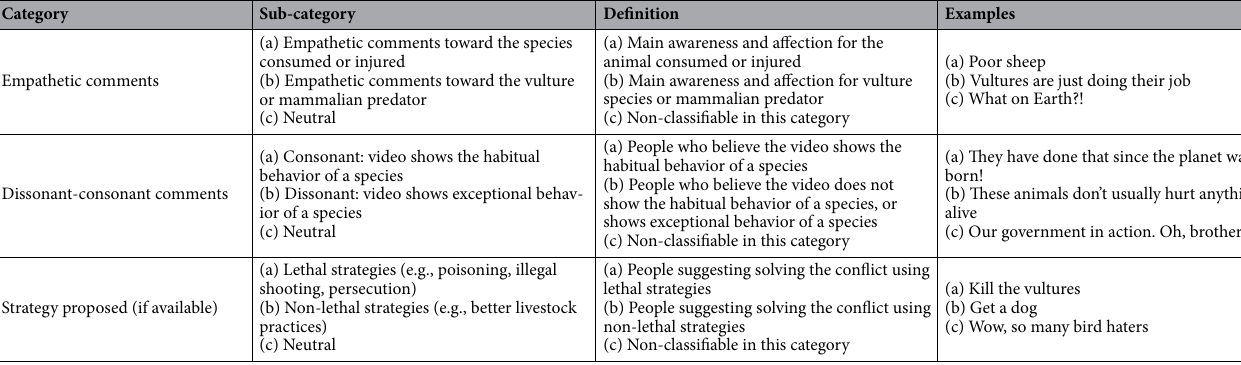
Table 2. Codification used for the comments posted in response to videos on vultures and predators uploaded onto